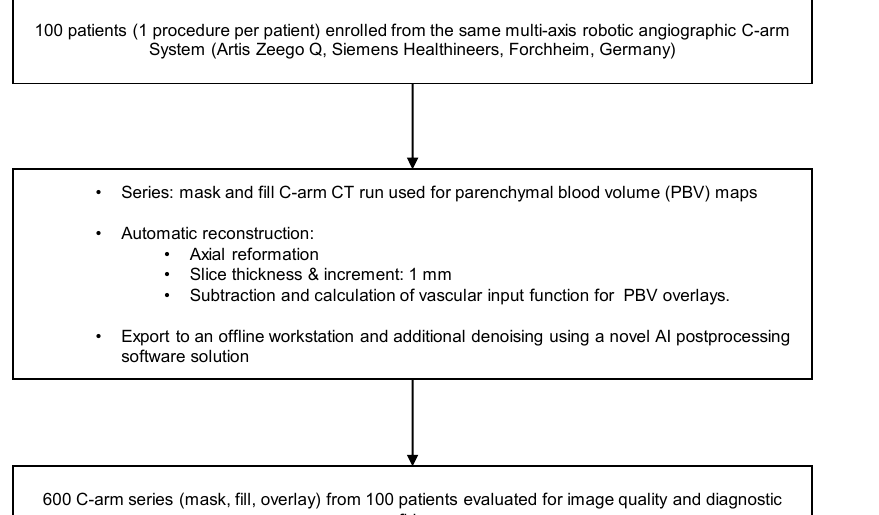
600 C-arm series (mask, fill, overlay) from 100 patients evaluated for image quality and diagnostic confidence